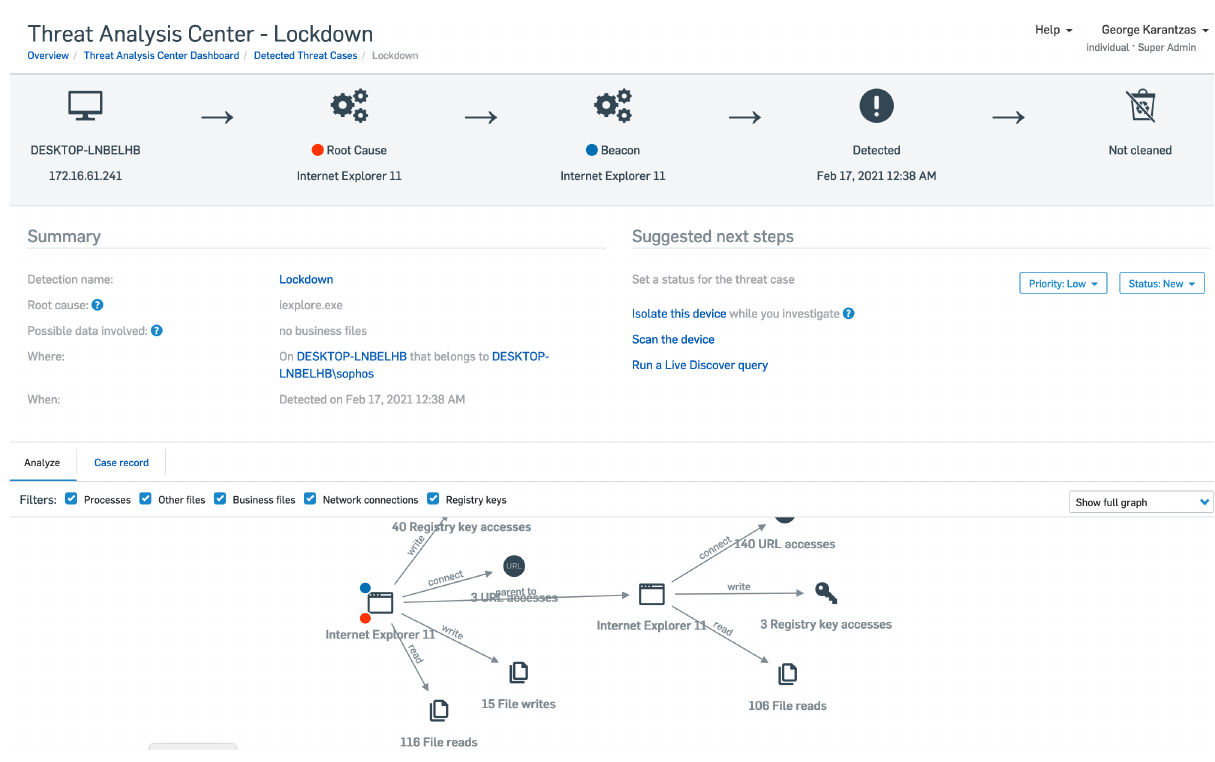
Figure 21. HTA was blocked by Sophos. Details and graph.